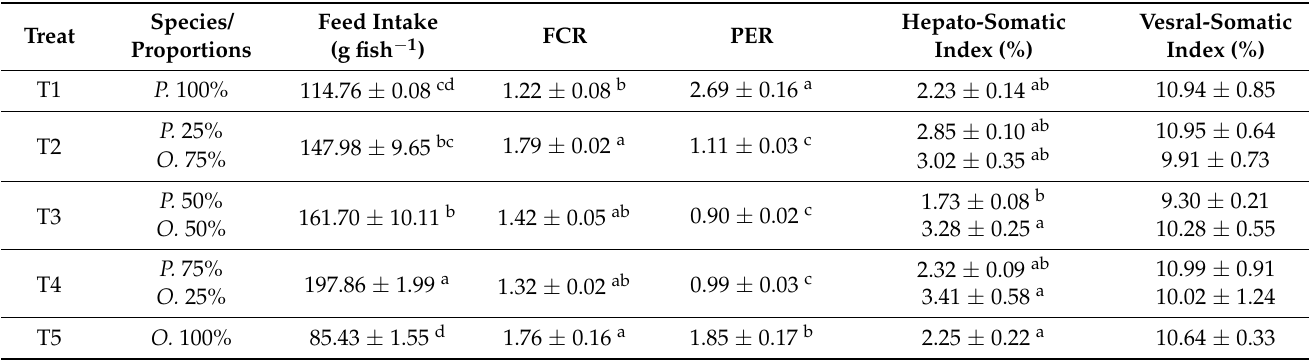
Table 3. Feed utilization and somatic indexes of juvenile striped catfish, Pangasianodon hypophthalmus (P.), and Nile tilapia, Oreochromis niloticus (O.), reared in monoculture and polyculture proportions for 14 weeks ( n = 3; means ± SE).